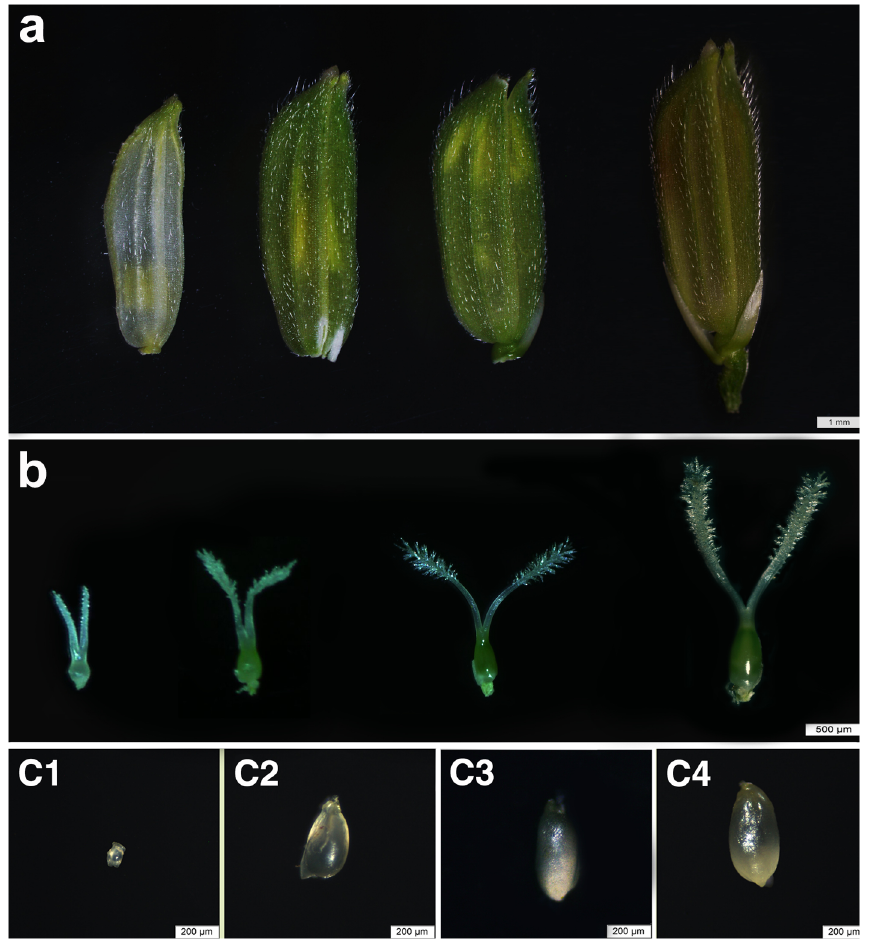
Fig 1. The Morphological observation of the developing florets, pistils and ovules. A Florets at three developmental stages. B Pistils at three developmental stages. C1 Ovule in OVR1 stage. C2 Ovule in